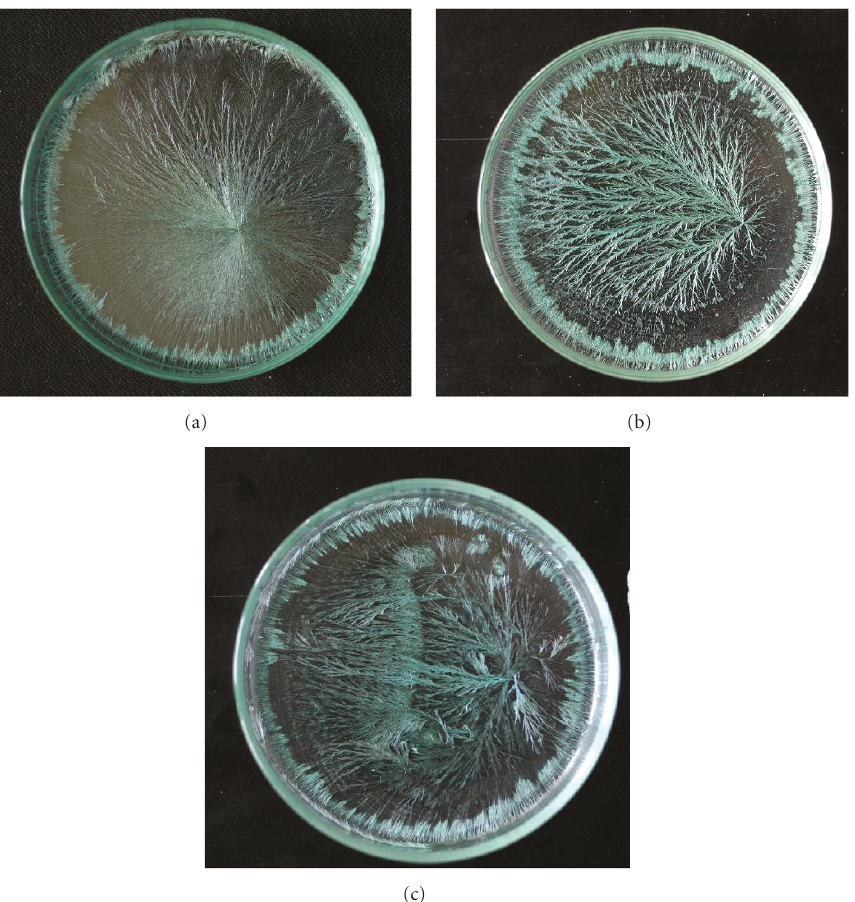
Figure 4: Biocrystallogram images of (a) fresh, (b) pureed, and (c) frozen sweet red peppers